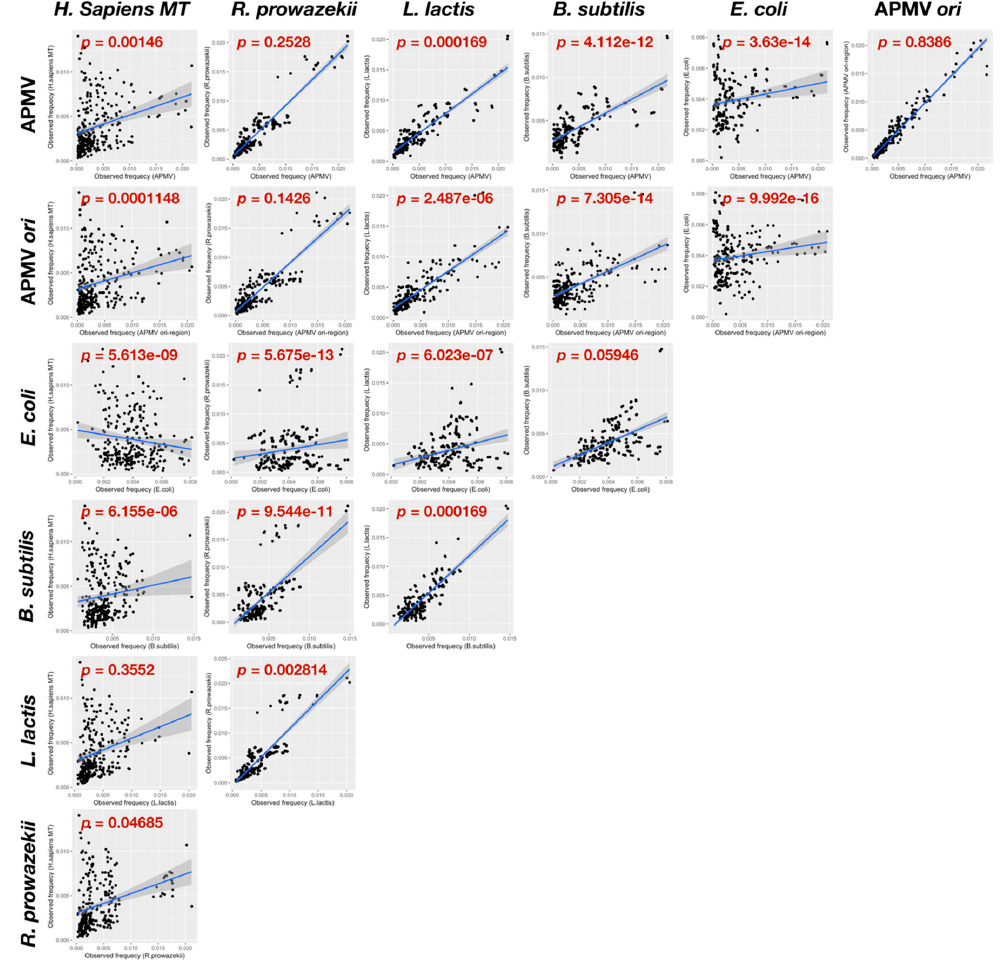
Figure 6. Comparative analysis of quartet nucleotide composition frequencies among APMV, human mitochondria ( H. sapiens MT), and four bacterial genomes ( Escherichia Coli , Bacillus subtilis, Lactococcus lactis, Rickettsia prowazekii) . Pairs of every frequency between two species were plotted with an approximate line. “APMV ori ” indicates the frequencies of sequence compositions in the estimated location of the ori region (375 – 385 kb region of AY653733.1). p -values in each top left corner of the graphs are the significant differences calculated between two groups as determined by KS test.